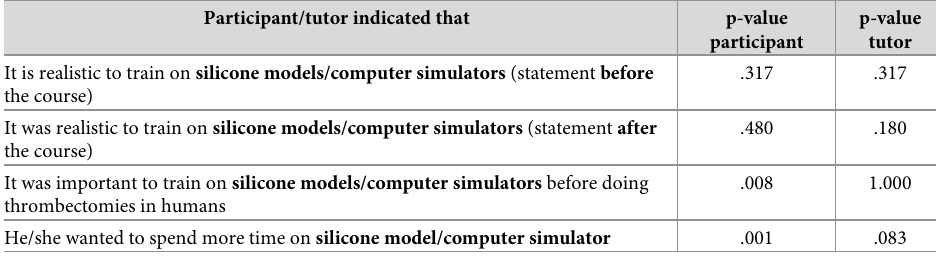
Table 4. Illustration of the statistical differences within a group. Participant/tutor indicated